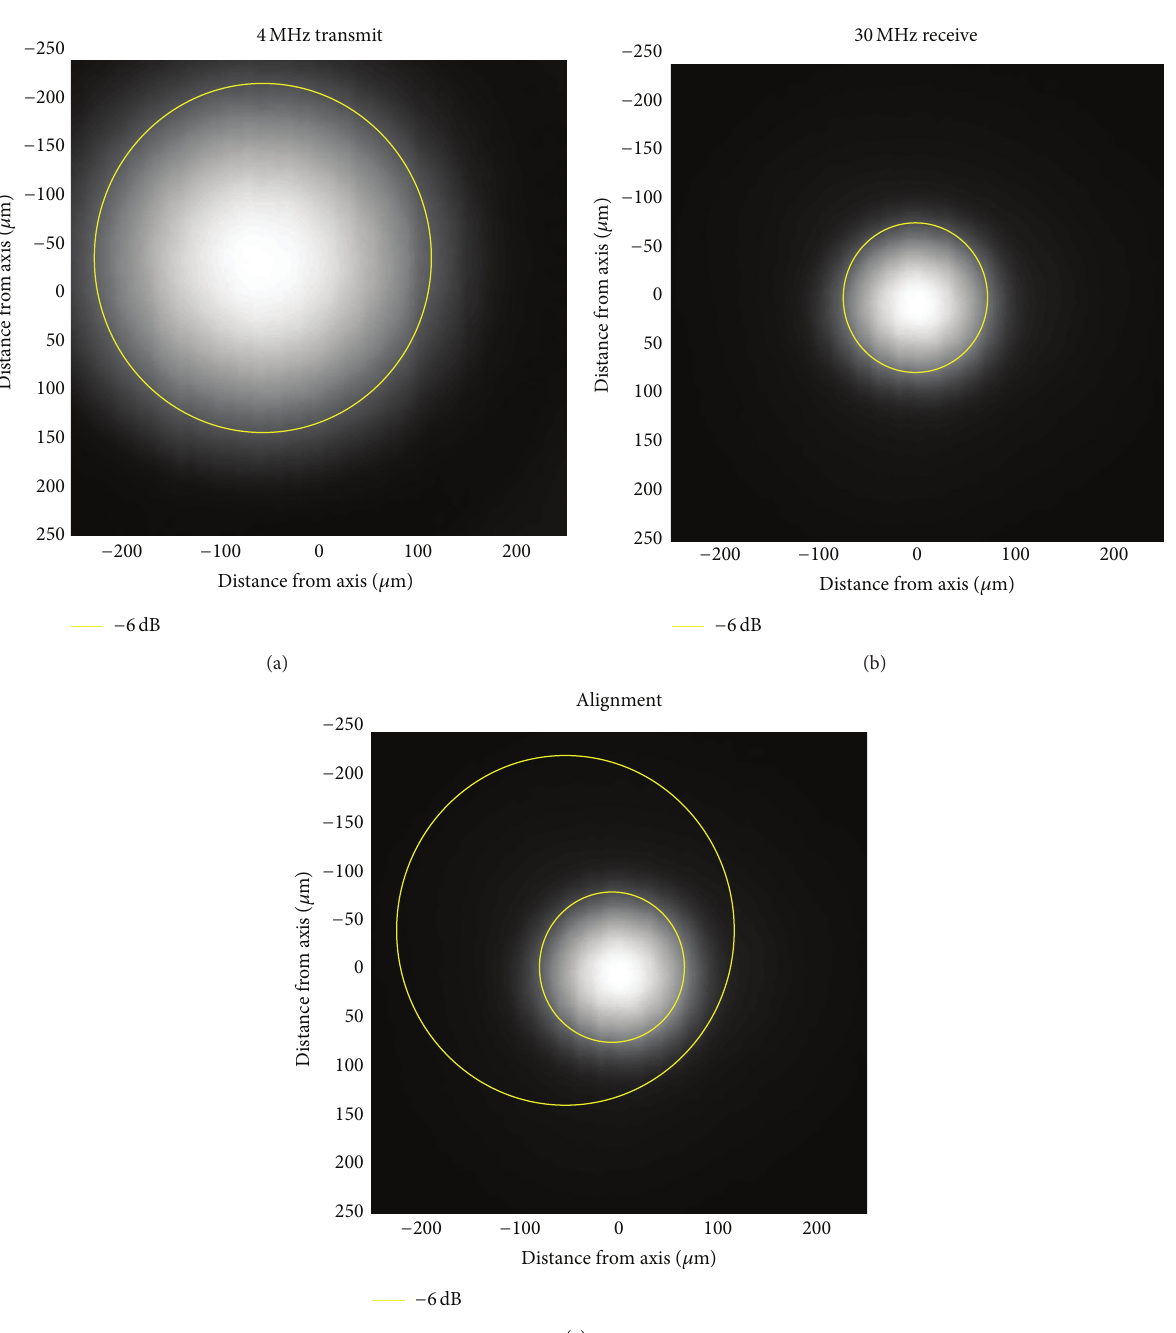
Figure 2: Beam plots showing the − 6dB beamwidth for the (a) 4MHz (298 𝜇 m) and (b) 30MHz (137 𝜇 m) elements. Panel (c) illustrates the confocal alignment of the transducers, where the circles approximate the − 6dB regions of the two transducers. There was a misalignment of approximately 90 𝜇 m of the two transducers on this prototype probe due to the challenge of the manufacturing process. Improving the element focal alignment is an obvious way to improve the performance of this system in future